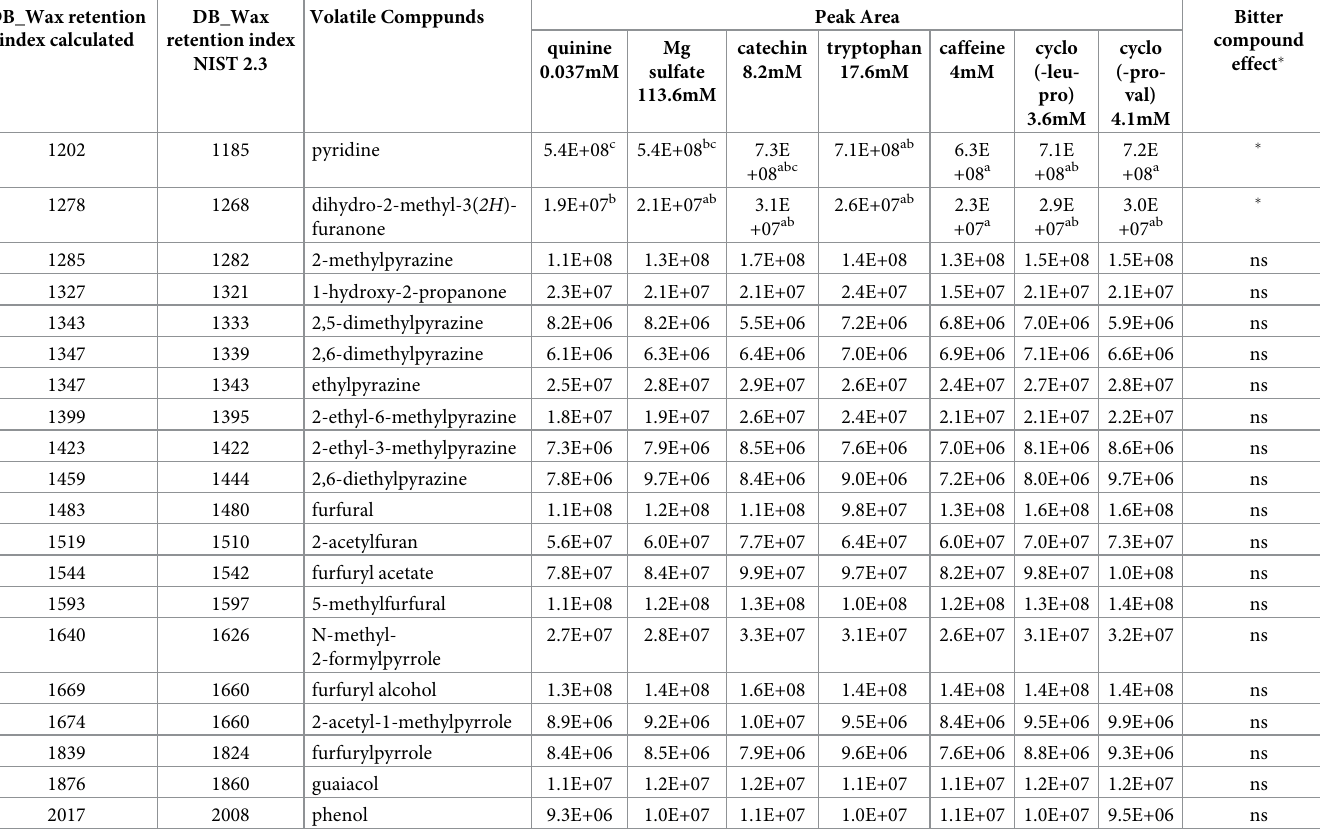
Table 3. Peak areas (GC/MS) of coffee volatile compounds in bitter matrices (caffeine, catechin, cyclo(-leu-pro), cyclo(-pro-val), magnesium sulfate, quinine and tryptophan). DB_Wax retention index